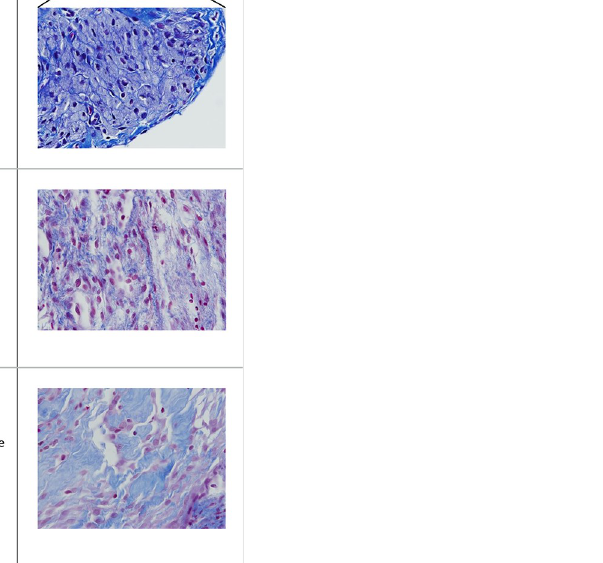
Fig 3. MT staining of caecal scar tissue